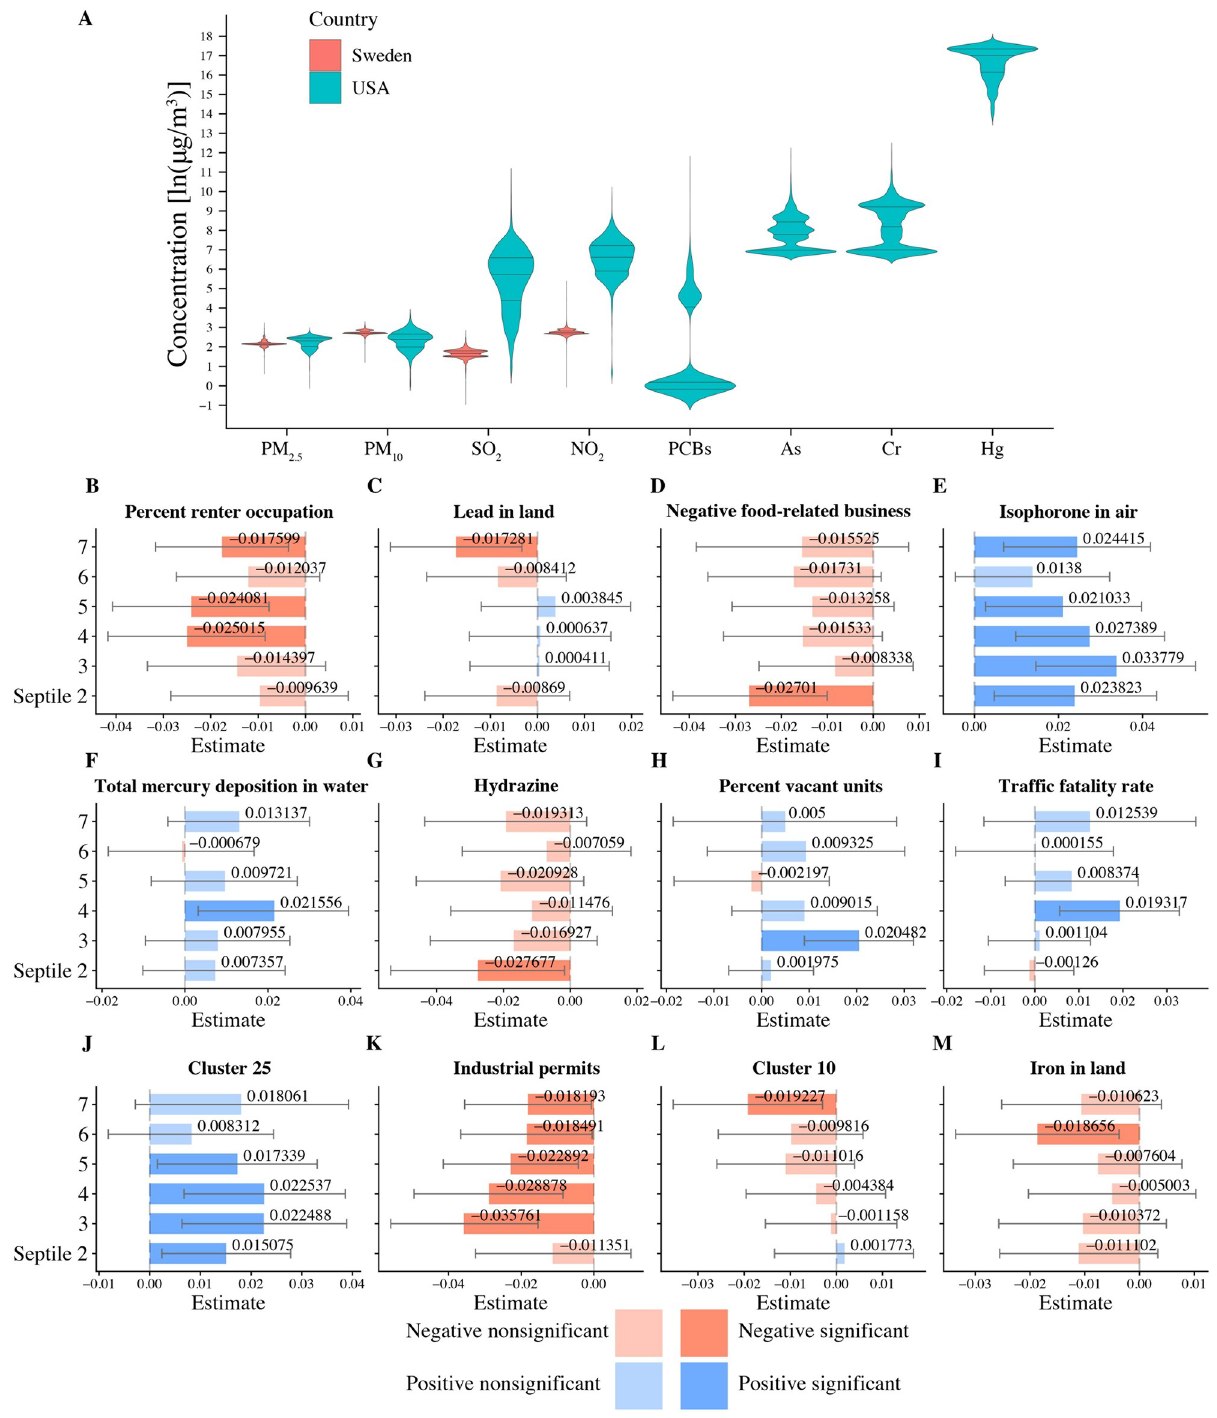
Fig 1. Airborne health-related substances and their association with the SRB. A : Comparison of airborne pollutant concentrations across the US (cyan violin plots) and Sweden (pink violin plots). Only 4 air components, fine particulate matter (PM 2.5 ), coarse particulate matter (PM 10 ), sulfur dioxide (SO 2 ), and nitrogen dioxide (NO 2 ) are measured in both countries. US counties appear to have higher mean pollution levels and are more variable in terms of pollution. B-M : A sample of 12 one-environmental factor logistic regression models that are most explanatory with respect to SRB. For each environmental factor, we partition counties into 7 equal-sized groups (septiles), ordered by levels of measurements, so that the first septile corresponds to the lowest and the highestnth septile to the highest concentration. Each plot shows bar plots of regression coefficients and 95% confidence intervals (error bar) of the second to the seventh septiles, with the first septile chosen as the reference level. We rank the 12 models by the